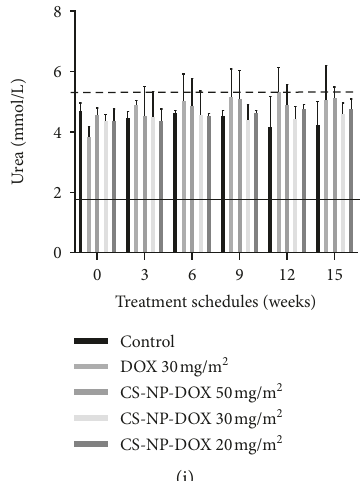
Figure 4: Effect of treatment groups from onset to 3 weeks after the 5th cycle on the haematological profile and serum biochemistry. (a) Red blood cells (RBCs) (10 6 /mm 3 ), (b) platelet cells (PLT) (10 3 /mm 3 ), (c) white blood cells (WBC) (10 3 /mm 3 ), (d) alkaline phosphatase (ALP) ( µ /L), (e) aspartate aminotransferase (AST) ( µ /L), (f) alanine aminotransferase (ALT) ( µ /L), (g) lactate dehydrogenase (LDH) ( µ /L), (h) creatinine kinase (CK) ( µ /L), (i) creatinine (Crea) ( µ mol/L), and (j) urea (mmol/L). Values are expressed as mean ± standard deviation. Different alphabets indicate statistical significance ( p < 0 . 05) between groups at different cumulative doses with a, b, c, and d representing significant difference with control, DOX 30mg/m 2 , CS-CaCO 3 NP-DOX 50mg/m 2 , CS-CaCO 3 NP-DOX 30mg/m 2 , and CS-CaCO 3 NP-DOX 20mg/m 2 ,